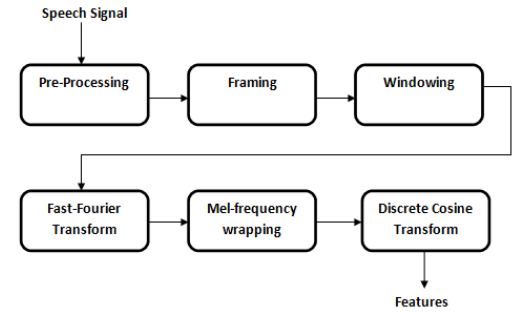
Figure 3. MFCC block diagram